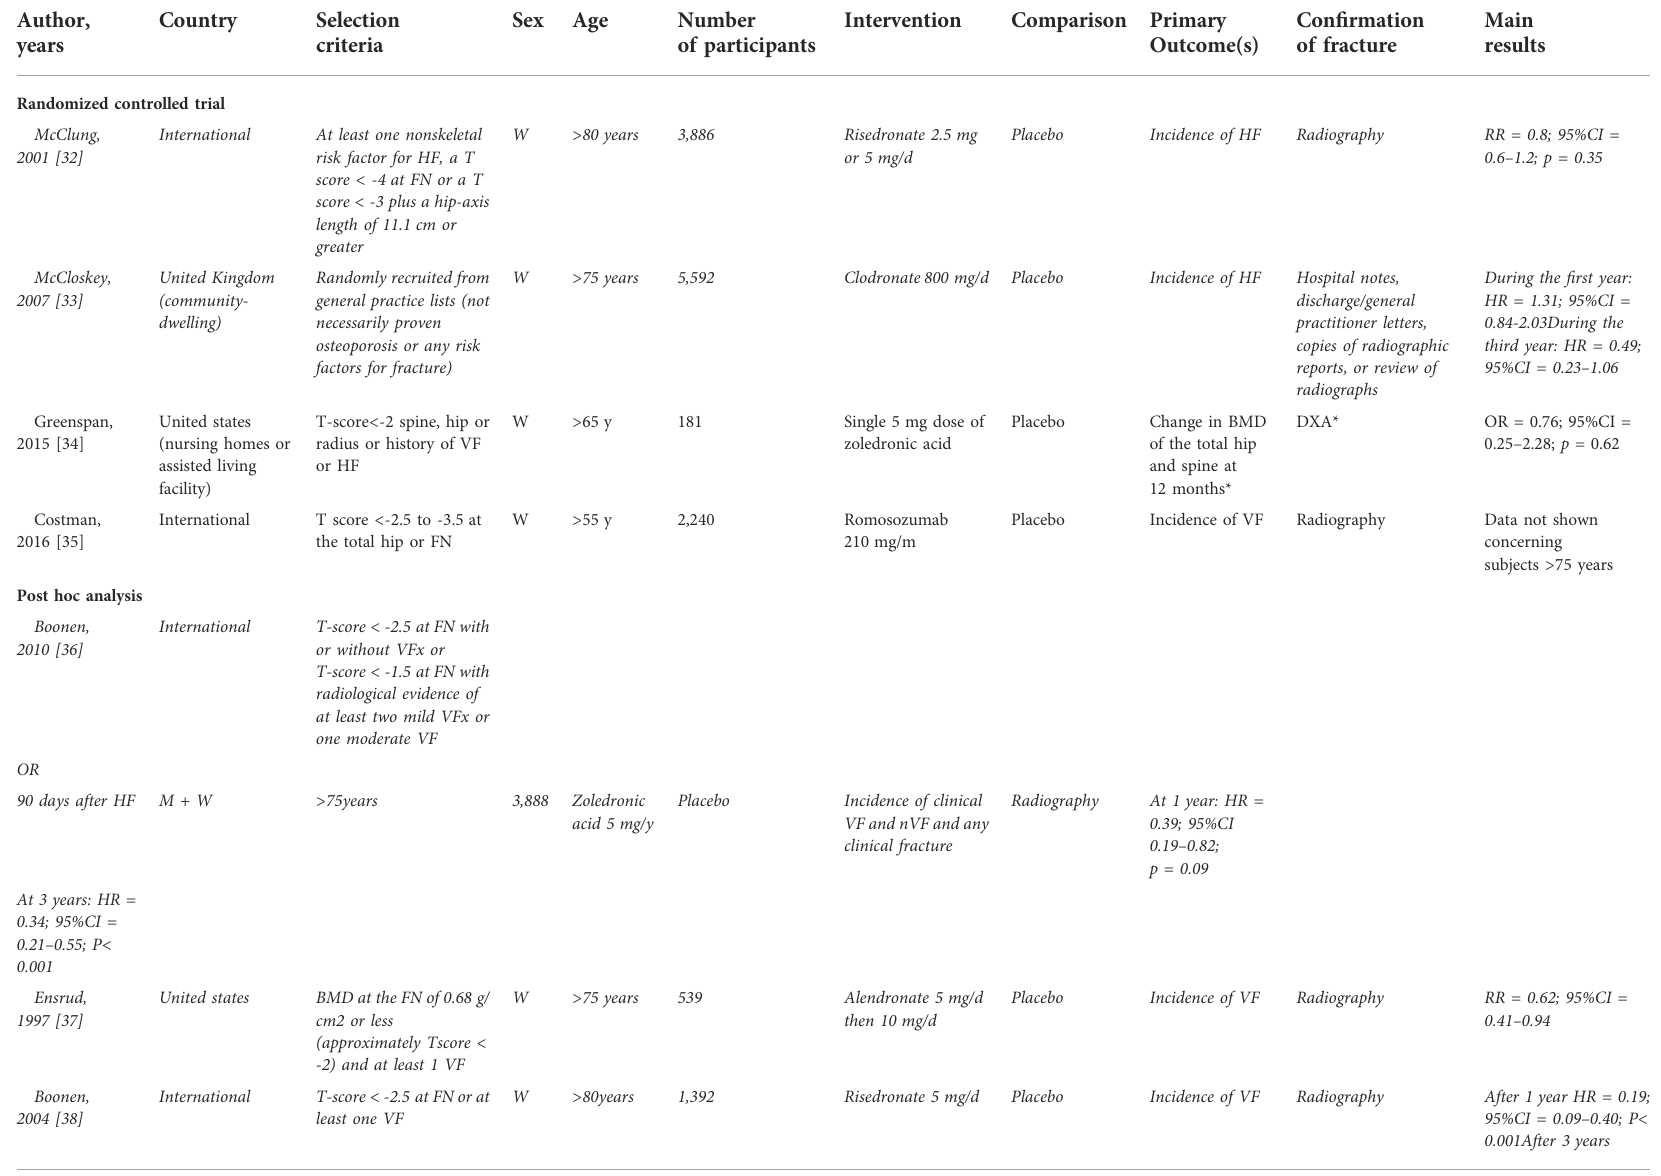
TABLE 1 Summary of included